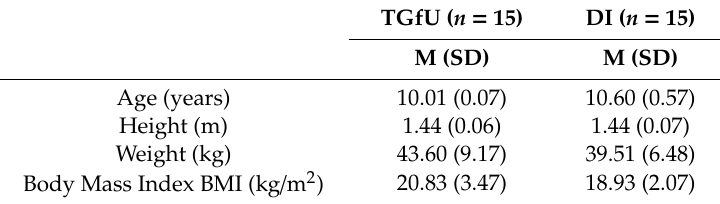
Table 1. Information the subjects about age, height, weight, and Body Mass Index (BMI) according to the pedagogical approach (Teaching Games for Understanding [TGfU] vs. Direct Instruction